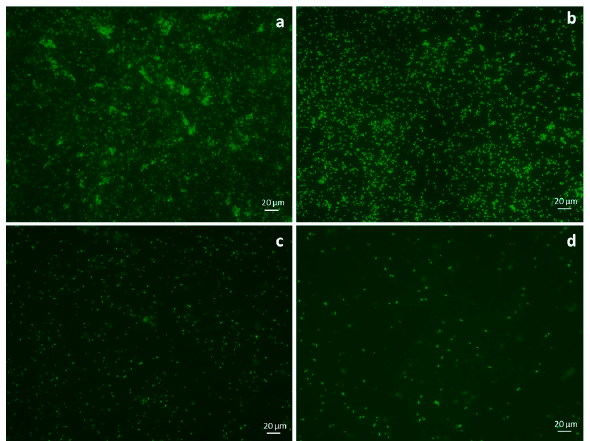
Figure 5. ( a ) Fluorescence microscopy on bacteria adhered on the multi-well plates (magnification